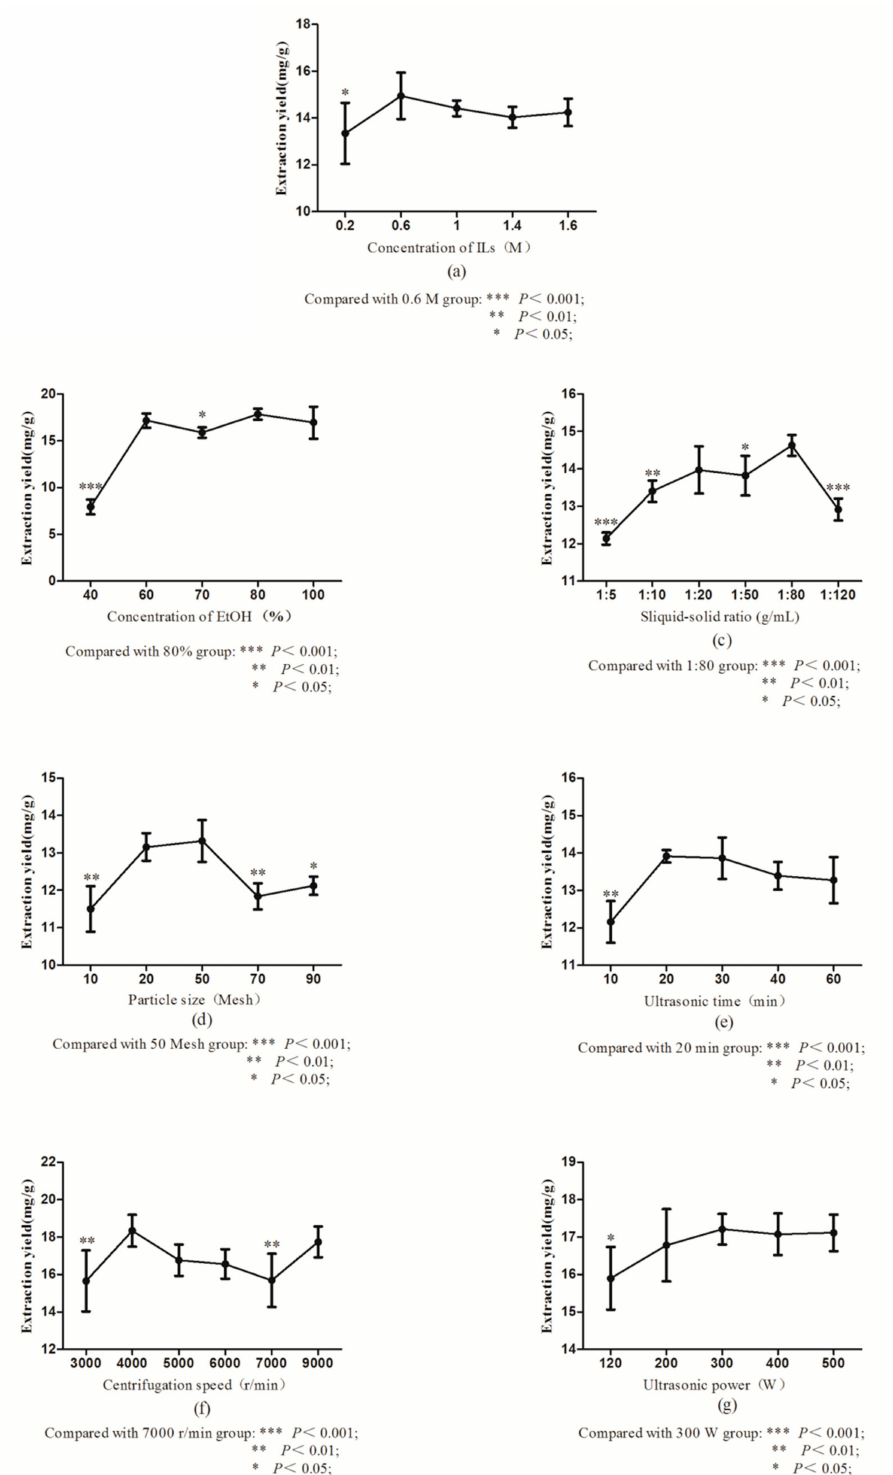
Figure 3. E ff ect of concentration of ( a ) ILs, ( b ) concentration of EtOH, ( c ) liquid–solid ratios, ( d ) particle size, ( e ) ultrasonic times, ( f ) centrifugation speed, and ( g ) ultrasonic power on seven compounds in Psoralea Fructus ( n =